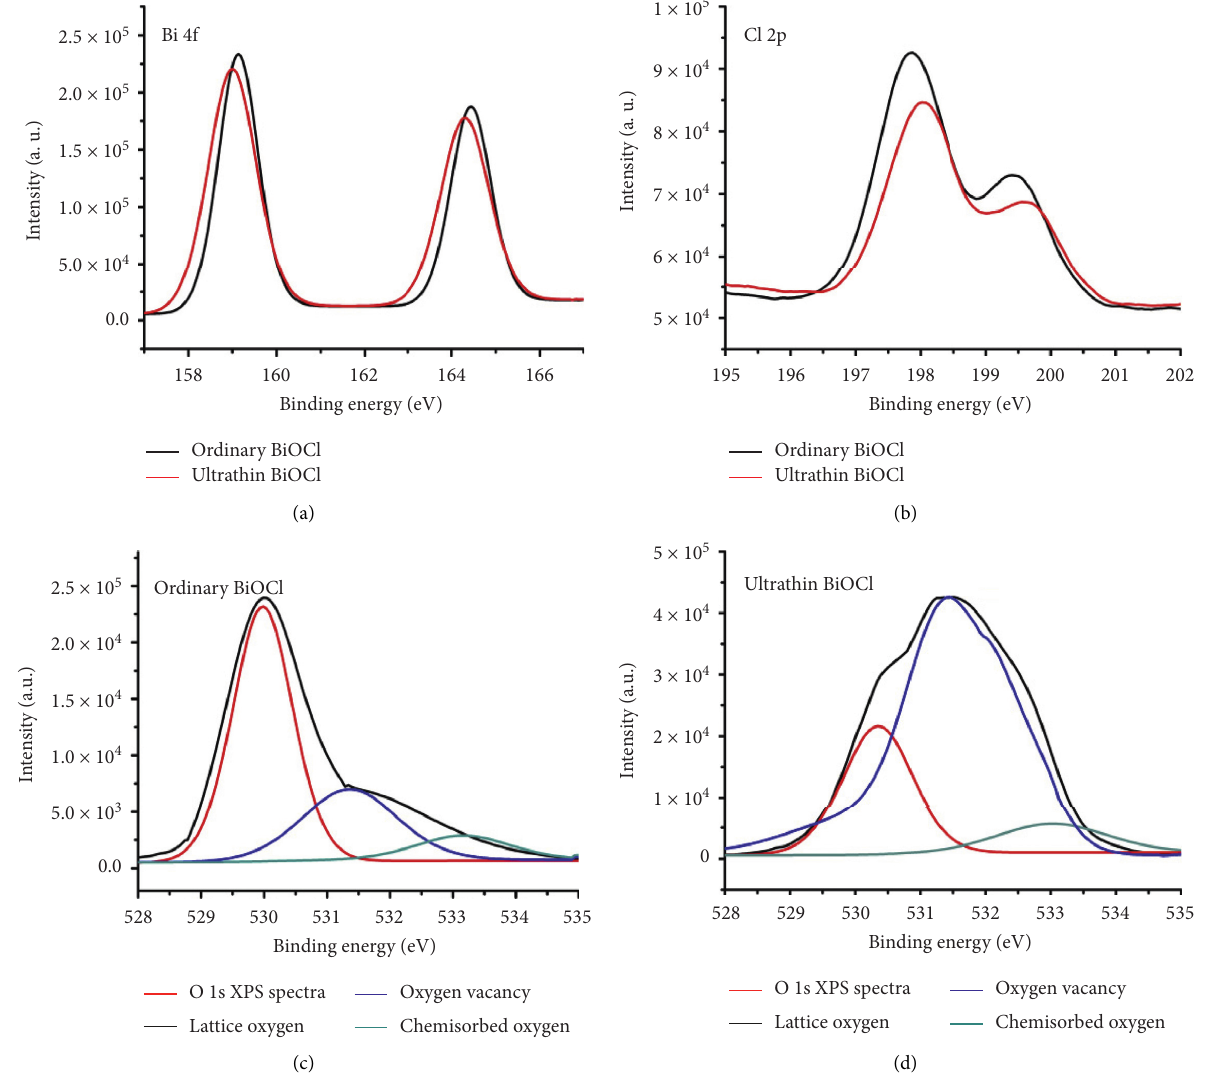
Figure 6: High-resolution Bi 4f (a), Cl 2p (b), and O1s (c, d) XPS spectra of ordinary BiOCl and ultrathin